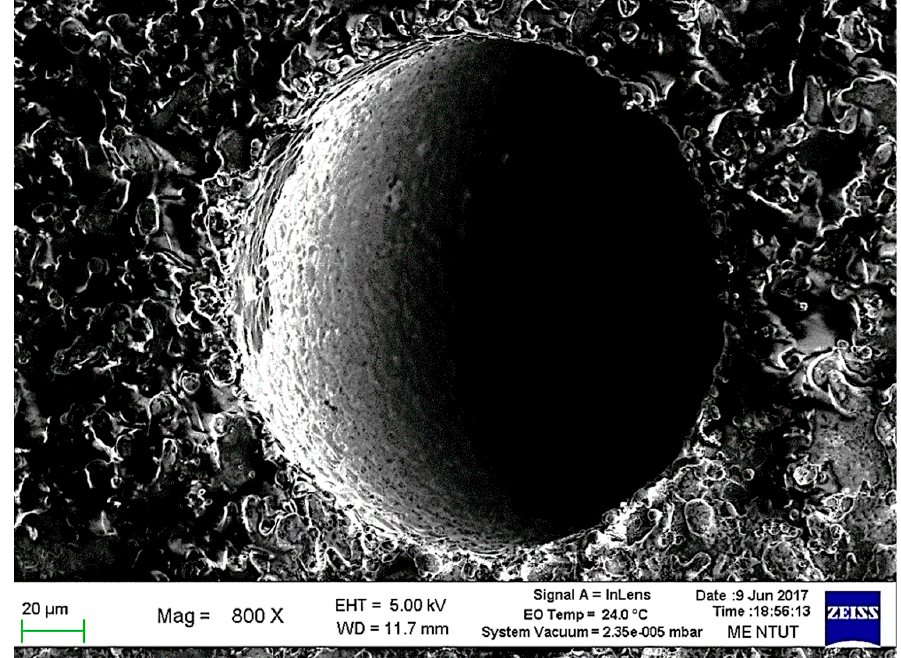
Figure 19. Surface of micro-hole drilling of high aspect ratio on WC-Co observed by SEM.